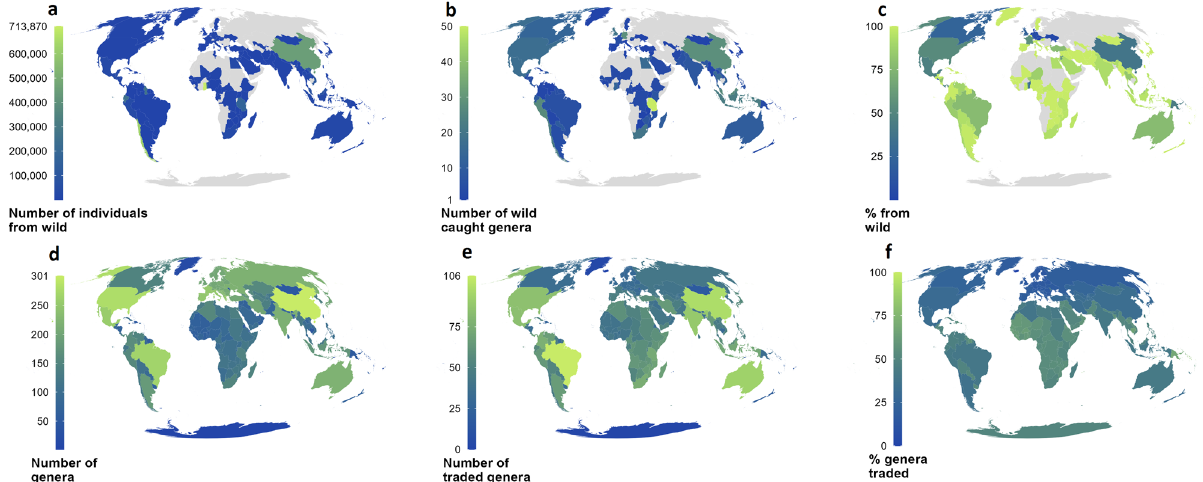
Fig. 6 The source of traded spiders and scorpions harvested from the wild. a – c show the source based on the origin listed in the LEMIS database. d – f show the natural distributions of all traded spiders and scorpions based on all data sources, number of species traded are shown in supplements. N.B., The natural distributions are only accurate to the country level, and in some cases represent extrapolation from broadly de fi ned distributions (e.g., a “ South American ” distribution would be mapped as including all countries in South